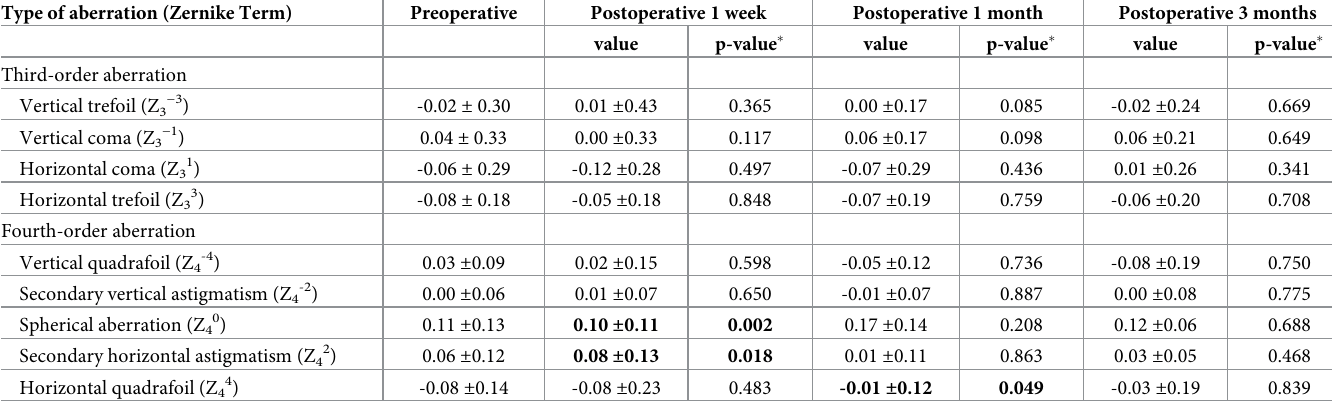
Table 5. Preoperative and postoperative 1 week, 1 and 3 months corneal HOAs with 6 mm diameter central corneal zone in group A (mean ± SD, μ